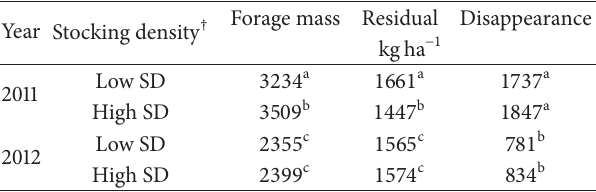
Table 3: Forage mass, residual forage mass, and forage disappear- ance by stocking density for two years.